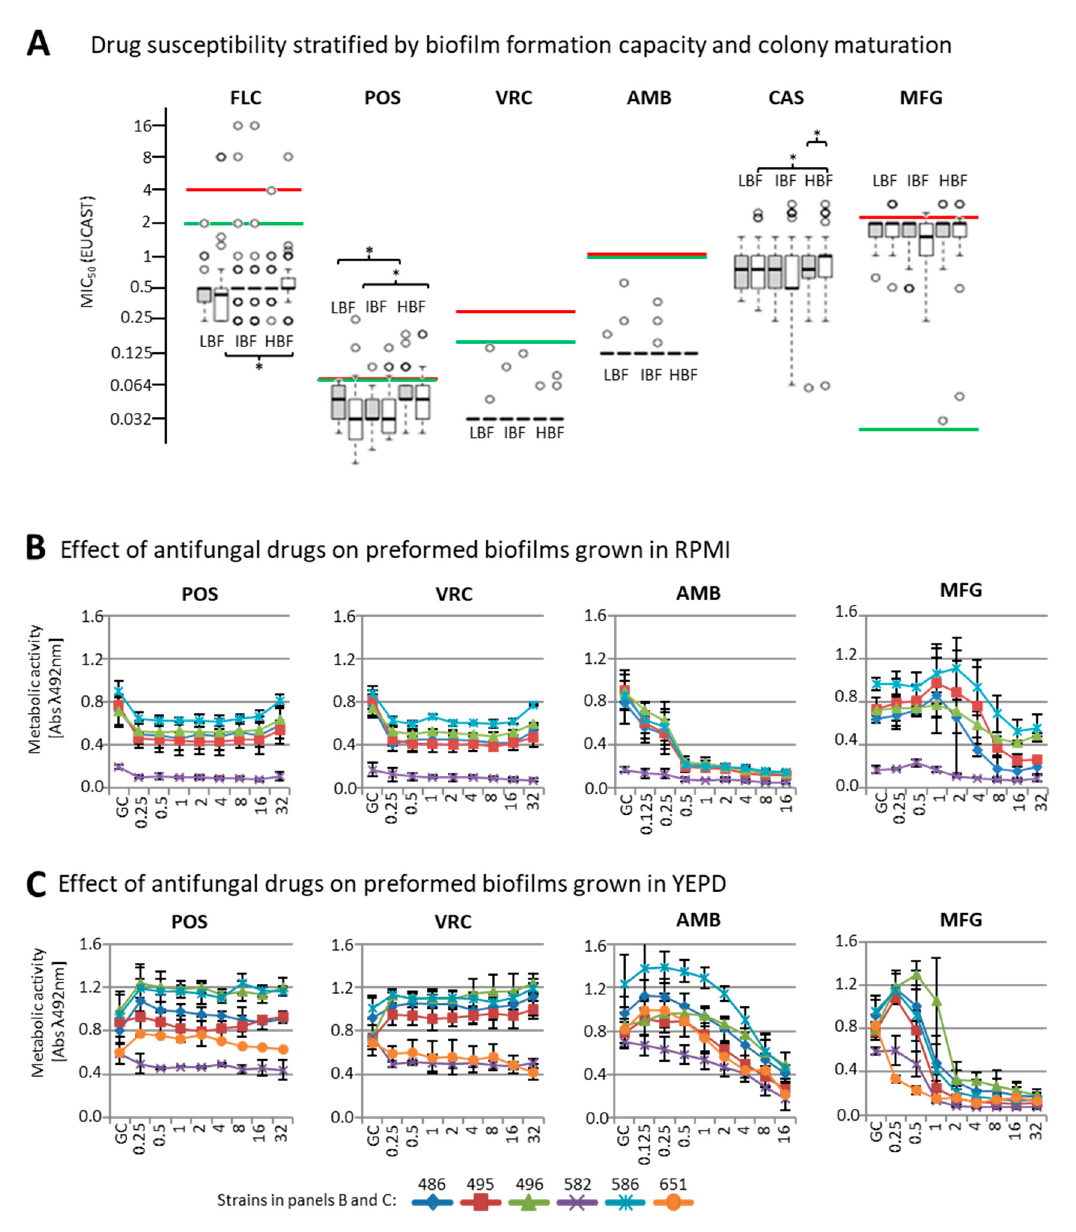
Figure 3. Drug susceptibility. ( A ) Biofilm formation-phenotype dependent susceptibility testing where inoculum was prepared from cells after 1 day of growth on Sabouraud dextrose agar (SDA) (gray boxes) and after 8 days of growth (white boxes) on the same plates, when colonies had fully developed morphotypes. For each substance tested, the values for 1 and 8-day inoculum are depicted for each group (LBF, IBF, and HBF). Red lines: EUCAST clinical breakpoint (R>); green lines, susceptible cut-off (S ≤ ). *: statistical significance ( B , C ) Effect of antifungal drugs on cell viability in pre-formed biofilms of selected biofilm-forming isolates tested in ( B ) RPMI (Roswell Park Memorial Institute )or ( C ) YEPD(yeast extract peptone dextrose) media.